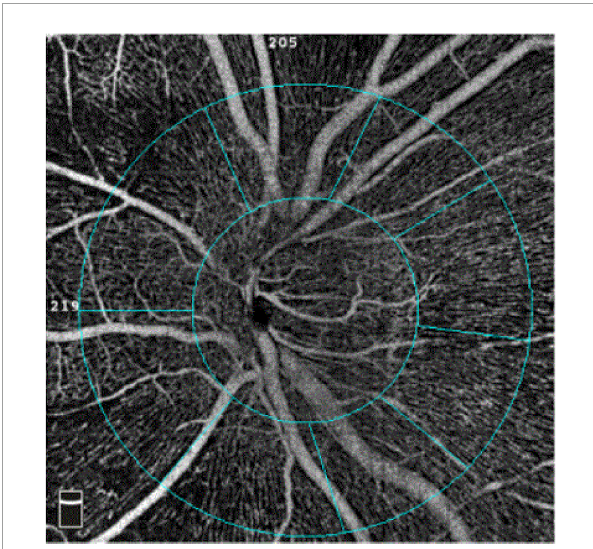
FIGURE1 Automatic measured images of optic disc by OCTA with a 4.5 × 4.5 scan pattern.